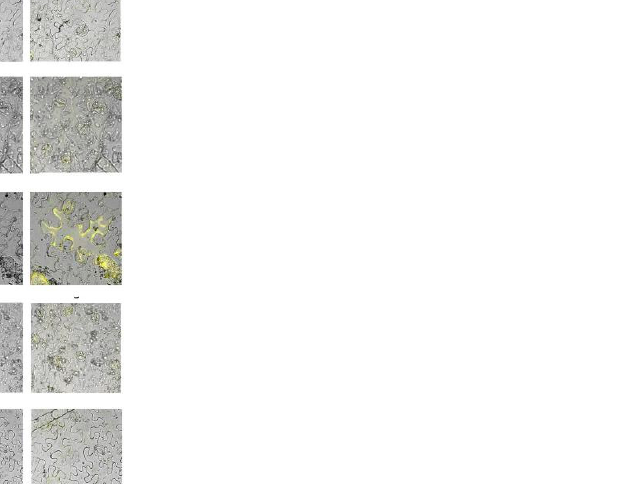
Figure 6. Analysis of protein–protein interactions via yeast two-hybrid experiment between RrLAZY1 and auxin-related proteins of R. rugosa . +++, ++, represent very strong and strong interac- tions, respectively. − , no interaction.